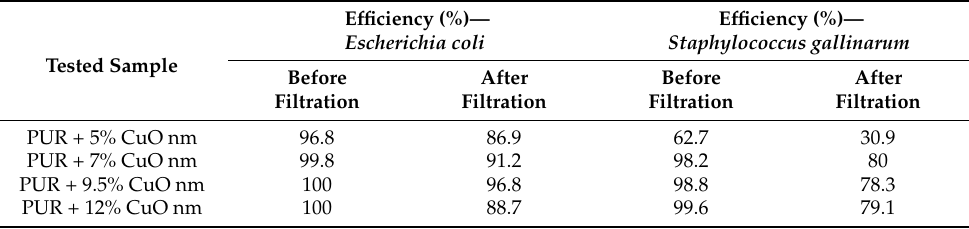
Table 8. Differences in antibacterial activity of samples with nanoparticles of CuO before and after treatment under the simulated conditions of water filtration (experiments with the electrode with a needle